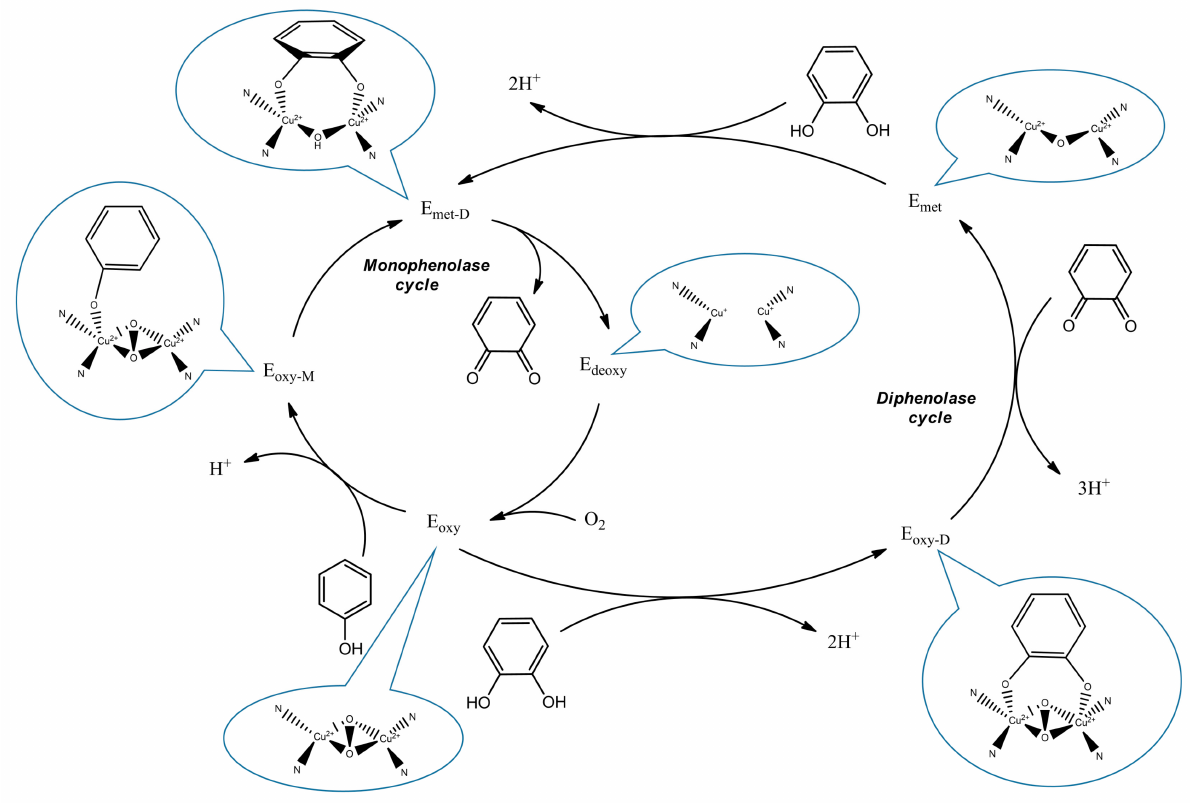
Scheme 1. Representation of tyrosinase states during monophenolase and diphenolase activity and catalytic site conformation in the blue